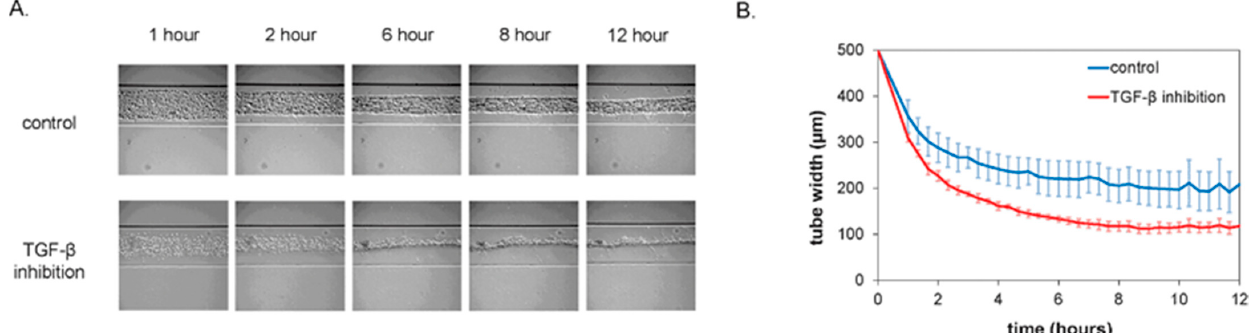
Figure 2 . Panel ( A ) represents the brightfield images captured the tubular structures of the pericytes in an OOC platform. Panel ( B ) represents the change in the tube width of the pericytes as a function of time. Reproduced from [32] with permission, © 2013 Royal Society of Chemistry.